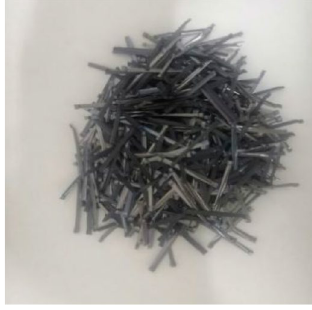
Figure 2. End hook type steel fiber.